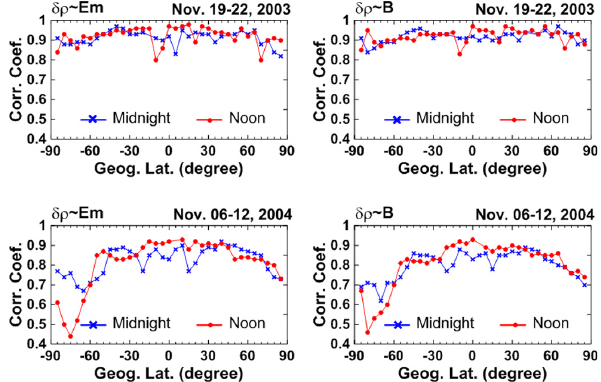
Fig. 6. The latitudinal variation of correlation coefficients of mass density changes with E m (left) and B (right) for different LT sec- tors during magnetic storm of 19–22 November 2003 (top) and 6– 12 November 2004